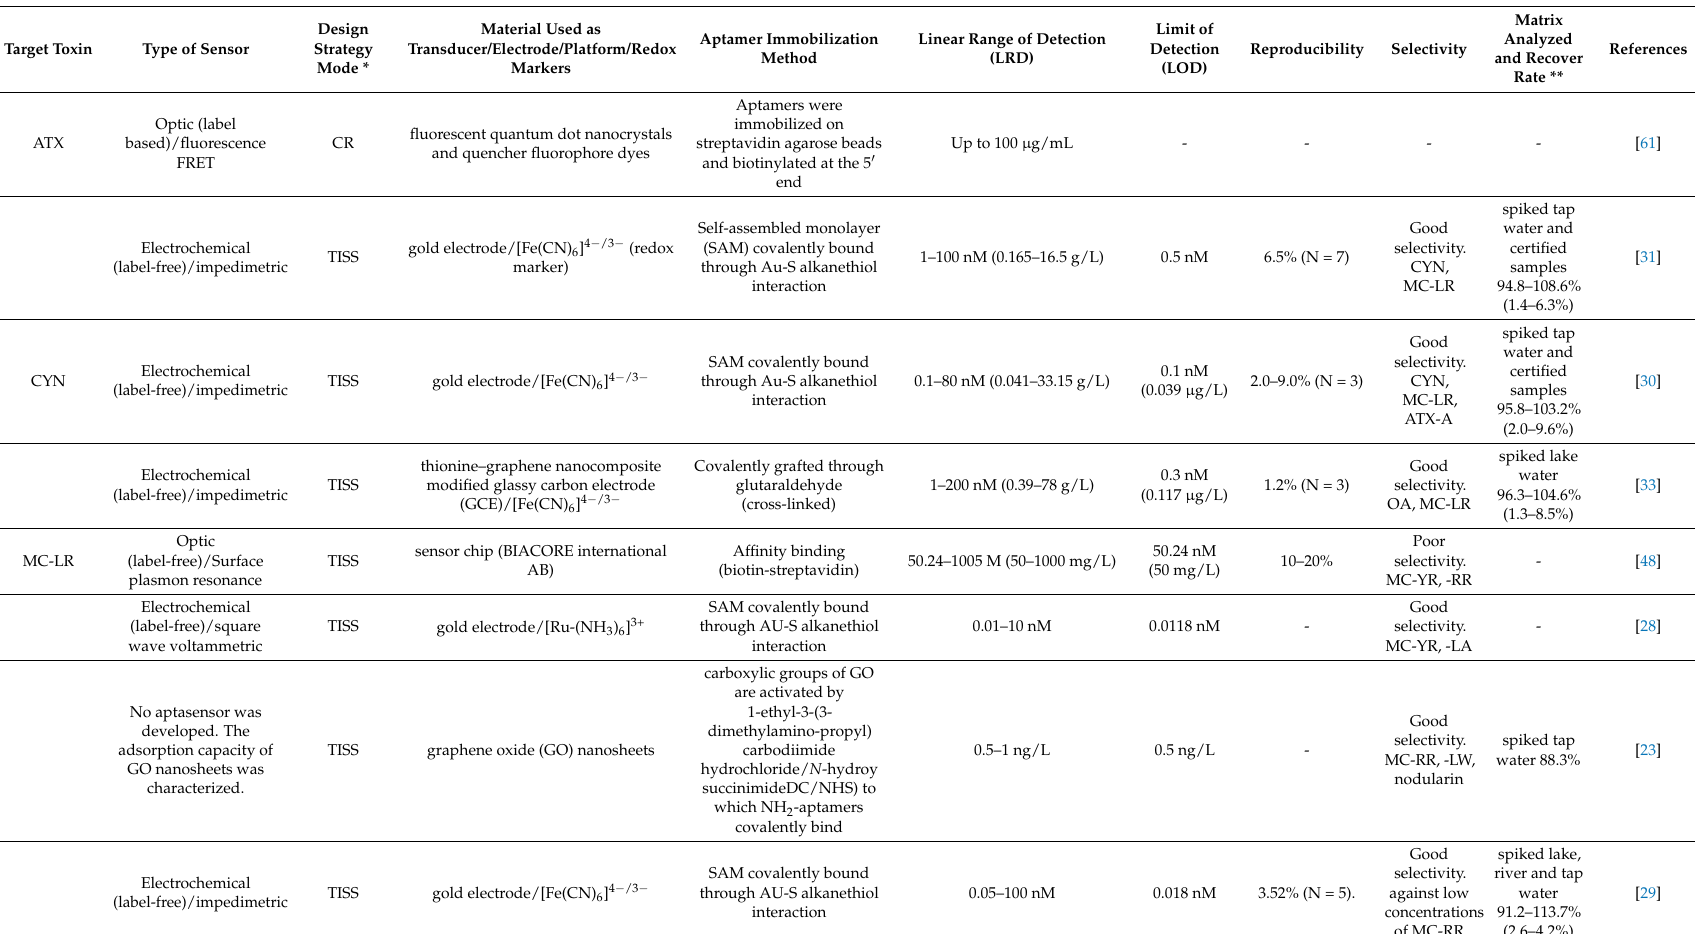
Table 2. Type of sensors, architecture and, characteristics of the aptasensors and matrices analyzed, used in the detection of aquatic toxins.